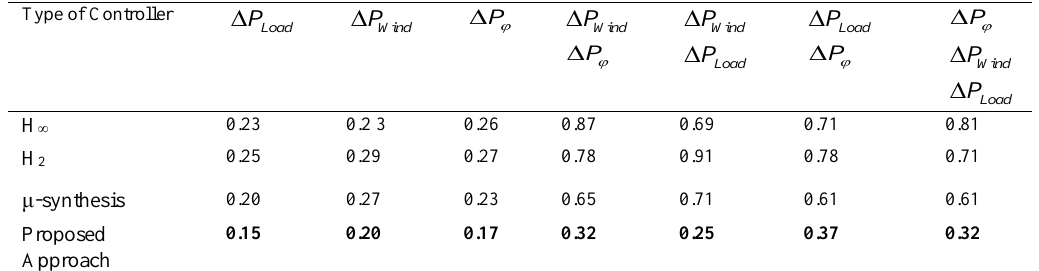
Table 1: Comparison of the proposed and alternative approaches against